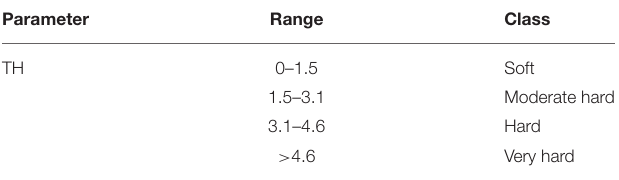
TABLE 5 | Classification of groundwater quality based on TH. Parameter